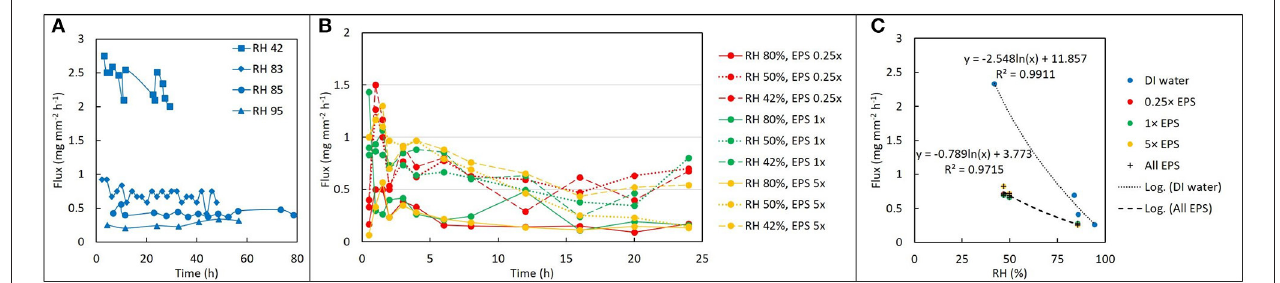
FIGURE 2 | Drying behavior as a function of EPS concentration and relative humidity (RH). (A) Change in water volume vs. time expressed as flux (mg mm − 2 h − 1 ) for deionized water at four different values of RH. (B) Evaporative flux from different EPS solutions at different values of RH: after an initially higher rate, the flux becomes approximately constant over time. (C) Time-averaged flux decays exponentially with increase in RH for both water (blue) and EPS. Note that although concentration of EPS does not seem to influence the flux at a given RH, the difference between evaporative flux for EPS solutions versus deionized water varies by a factor of 2–4 times depending on RH.